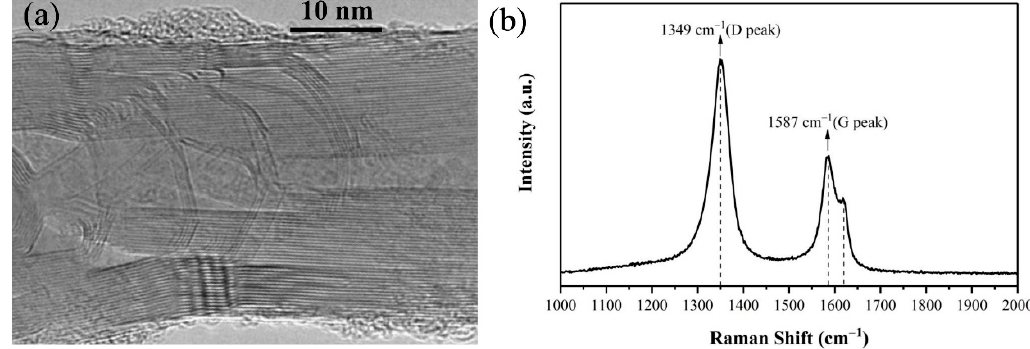
Figure 3. ( a ) HRTEM image and ( b ) Raman spectrum of the prepared CNTs.